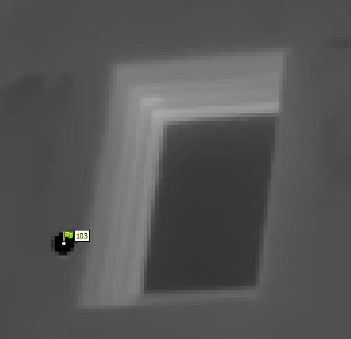
Figure 1. Passive control point visible on thermal image.